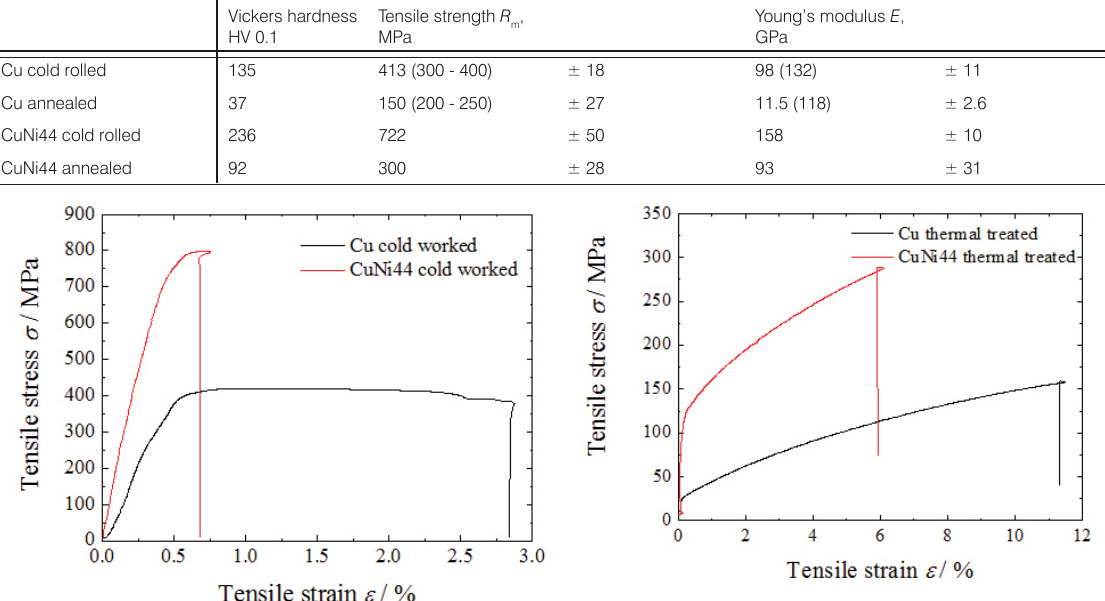
Figure 8. (Left): Comparison between cold worked Cu and Cu-Ni44 substrates. (Right): Comparison between thermal treated Cu and CuNi44